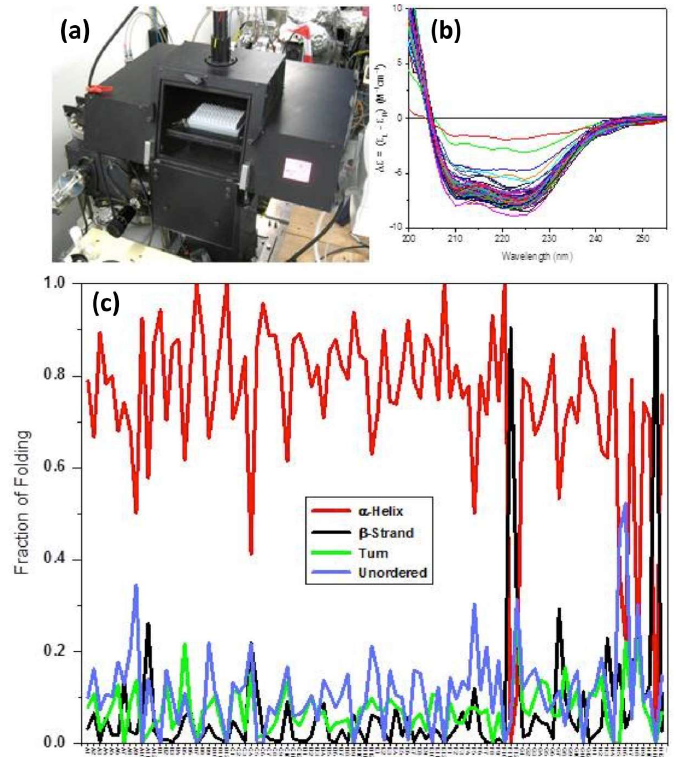
Figure 6. Synchrotron radiation circular dichroism (SRCD) measurements of the LacY transporter using the B23 beamline at Diamond (https: // www.diamond.ac.uk / Instruments / Soft-Condensed-Matter / B23.html). ( a ) Picture of the end station at B23 beamline that enables high-throughput screening. It has been designed to accommodate the 96-well multiplates made of fused quartz (Suprasil, Hellma); ( b ) SRCD spectra of the bacterial transporter LacY. Each of the 96 distinct solutions of the MemGold2 (Molecular Dimensions) screen contained about 15 µ L of 0.5 mg / mL of LacY. Measurements were done using a pathlength cell of 0.02 cm; ( c ) Percentage of α -helical content (and other secondary structure features) across the 96 MemGold2 crystallisation